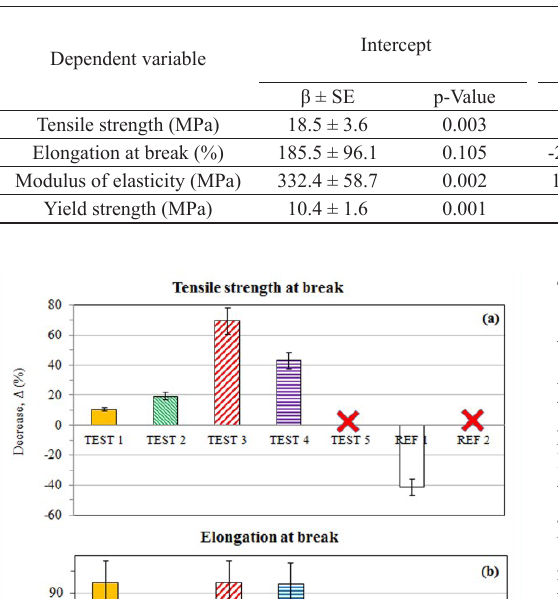
Table 6. The results of linear modelling stress-strain properties of the samples before and after soil test.